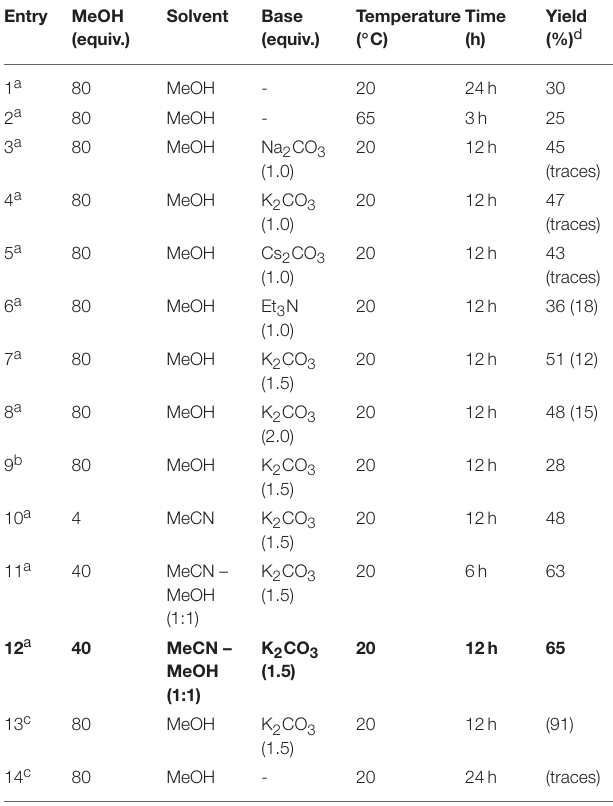
TABLE 1 | Reaction optimisation for imidate 6a synthesis. Entry MeOH